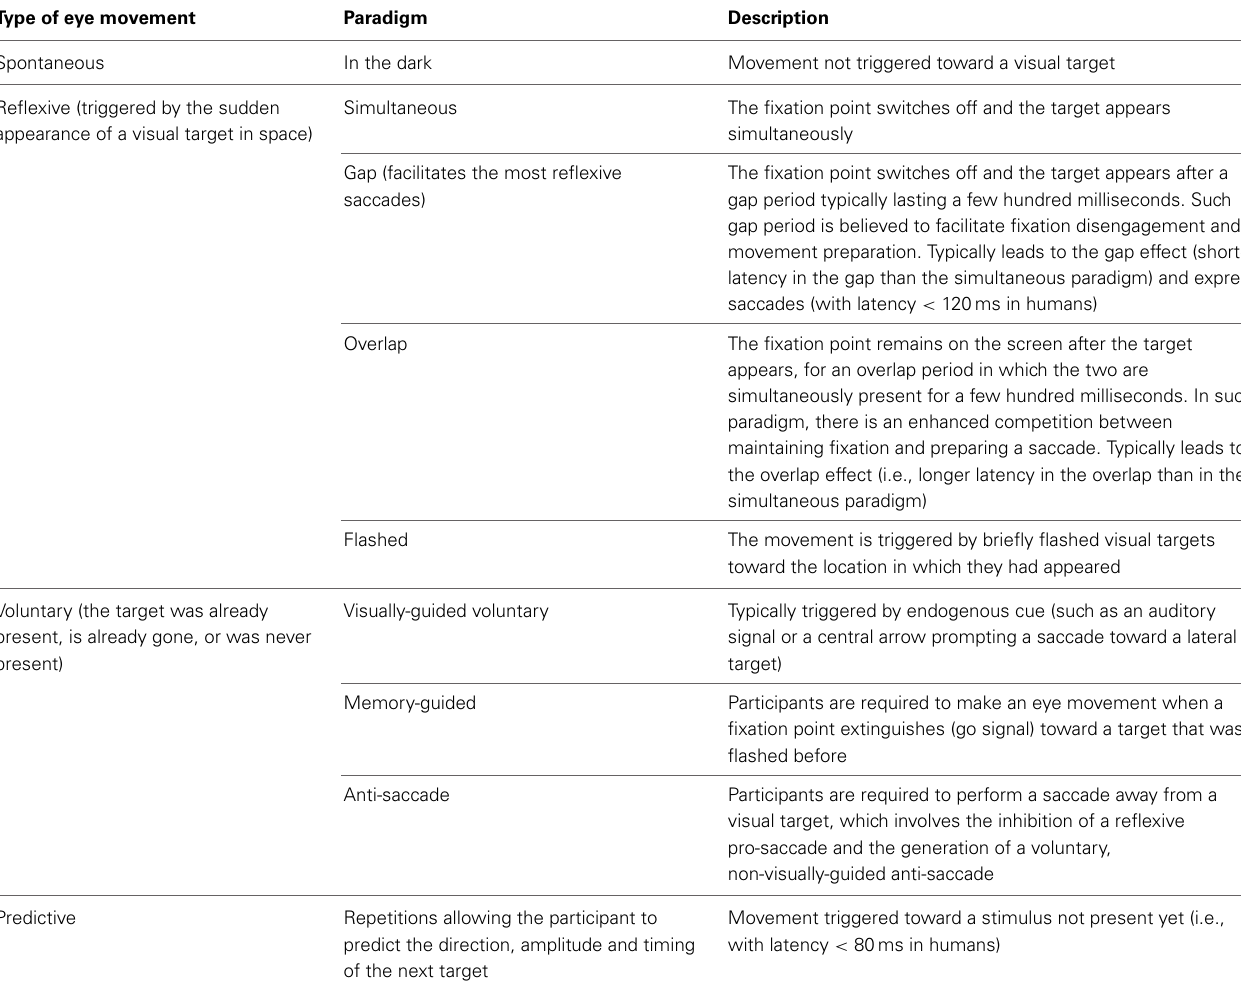
Table 3 | Types of eye movements and experimental paradigms to elicit